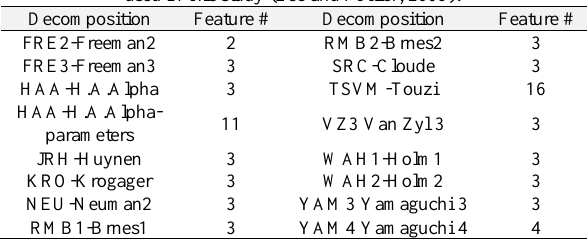
Table 1: Coherent and non-coherent decomposition of the sample used in this study (Lee and Pottier,